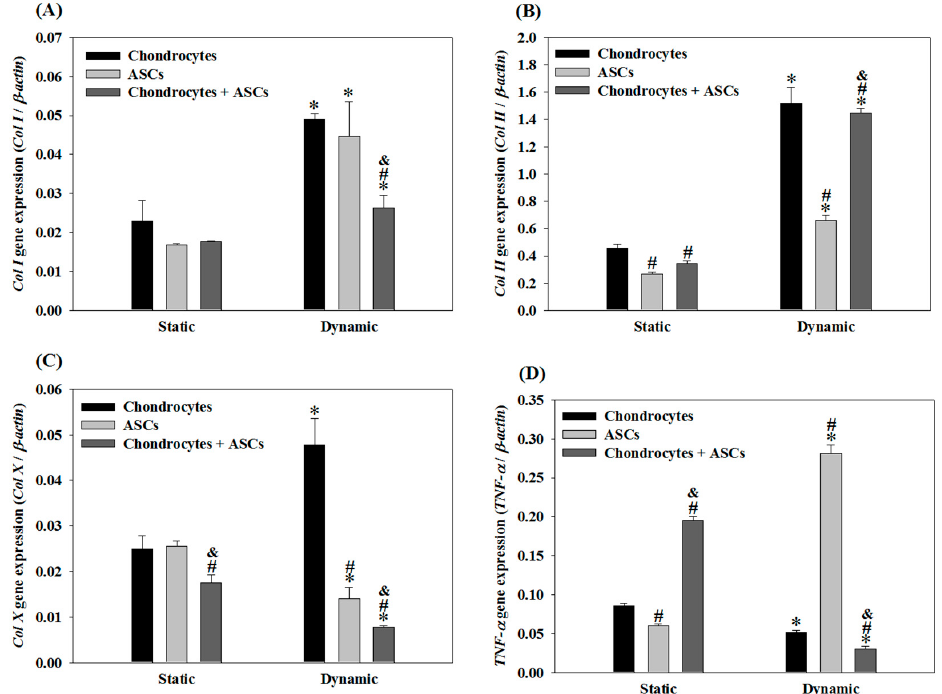
Figure 4. The gene expression of Col I ( A ); Col II ( B ); Col X ( C ) and TNF- α ( D ) when chondrocytes, adipose-derived stem cells (ASCs) or chondrocytes + ASCs were cultured in cryogel scaffolds for 14 days under static or cyclic compressive loading (frequency = 1 Hz, strain = 20% and duration = 3 h/day) conditions. Cell number: 10 5 chondrocytes/scaffold for the chondrocytes group; 10 5 ASCs/scaffold for the ASCs group; 5 × 10 4 chondrocytes/scaffold and 5 × 10 4 ASCs/scaffold for the chondrocytes + ASCs group. * p < 0.05 compared with the static group; # p < 0.05 compared with the chondrocytes group; & p < 0.05 compared with the ASCs group.